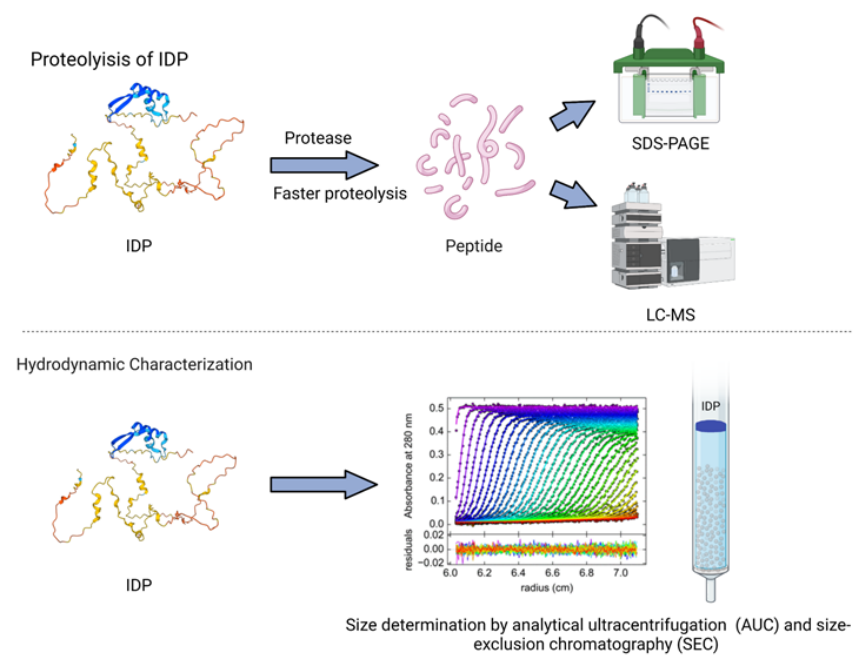
Figure 2. IDPs undergo faster proteolysis with enzymatic digestion compared to the structured proteins. The digested peptides are further analyzed using SDS-PAGE and LS-MS techniques. Tech- niques such as analytical ultracentrifugation and size-exclusion chromatography help to characterize the hydrodynamic size of IDPs.